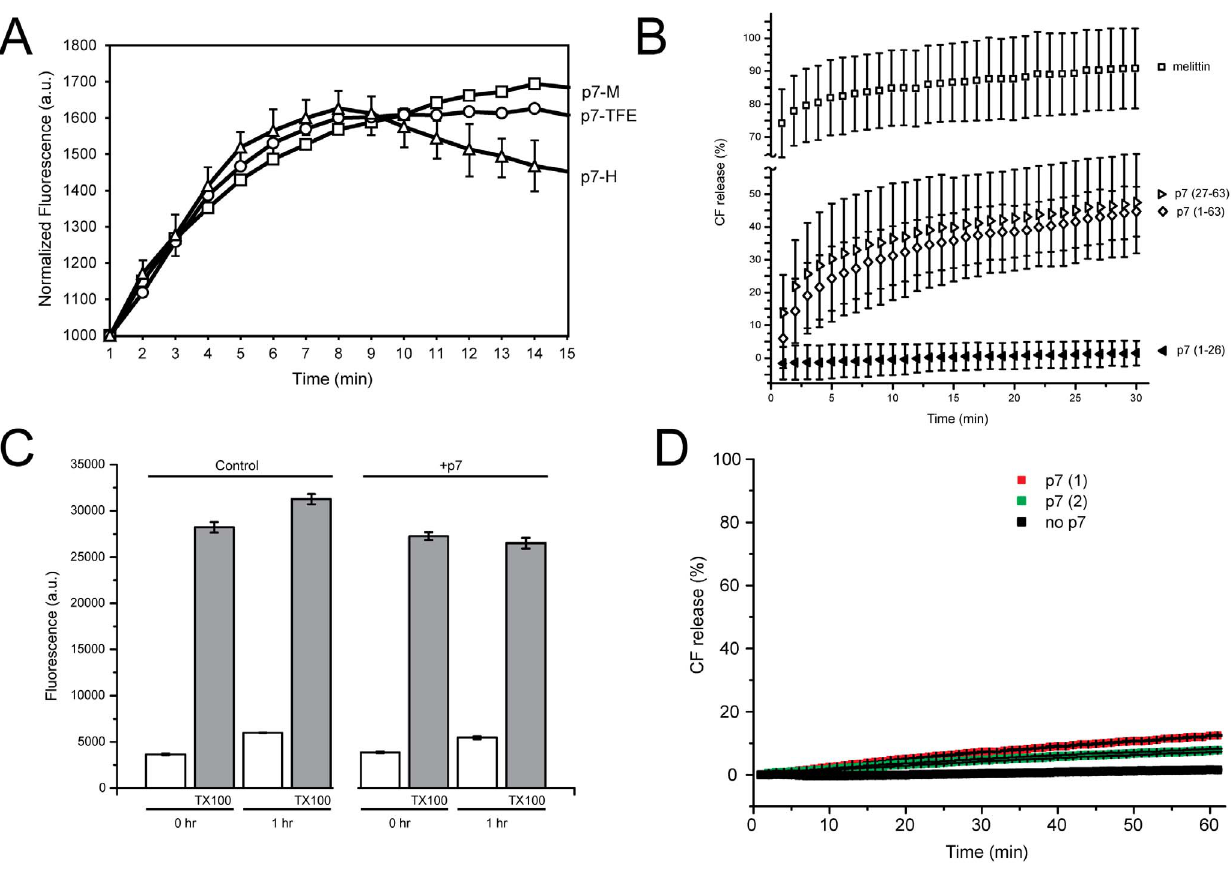
Figure 5. CF release liposome assay. (A) aliquots of p7 in methanol (M), TFE (TFE) or HFIP (H) were added to CF-loaded PAESC liposomes and fluorescence values were measured every minute; (B) Comparison of CF release results of full length p7 versus p7 fragments and melittin. Experimental conditions were as in (A), except that each peptide was added in methanol and peptide:lipid molar ratio was 1:10. Error bars (1 SD) are the result of 3 independent measurements; (C) same experiment, but p7 was incorporated into the liposomes by the dyalisis method after freeze- thaw and extrusion. Fluorescence values were measured immediately (0 h) after removing excess CF and after one hour (1 h). Liposome without p7 was used as control, and TX100 was added to measure total amount of CF incorporated. Error bars (1 SD) are shown only for one trace for clarity, and are the result of 3 independent measurements; In (A) and (B), no effect was observed when the liposomes were preincubated with up to 100 m M rimantadine; (D) kinetics of CF release when liposomes were extruded, where p7(1) and p7(2) represent samples containing p7 reconstituted with or without detergent solubilization steps, respectively.